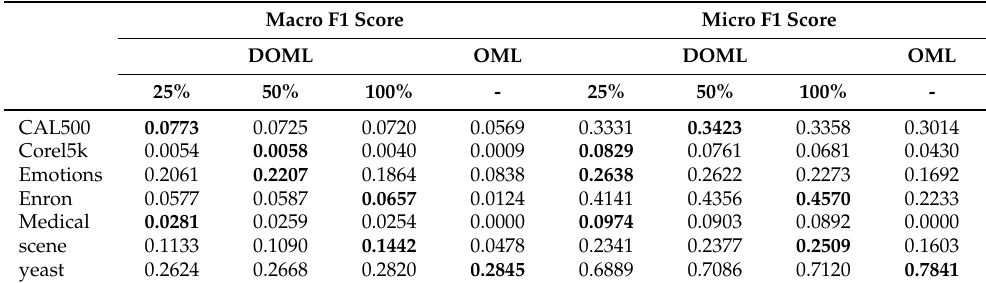
Table 7. F1 Score of DOML in a 20-node network with different connectivity and OML with same amount of instances as each node.